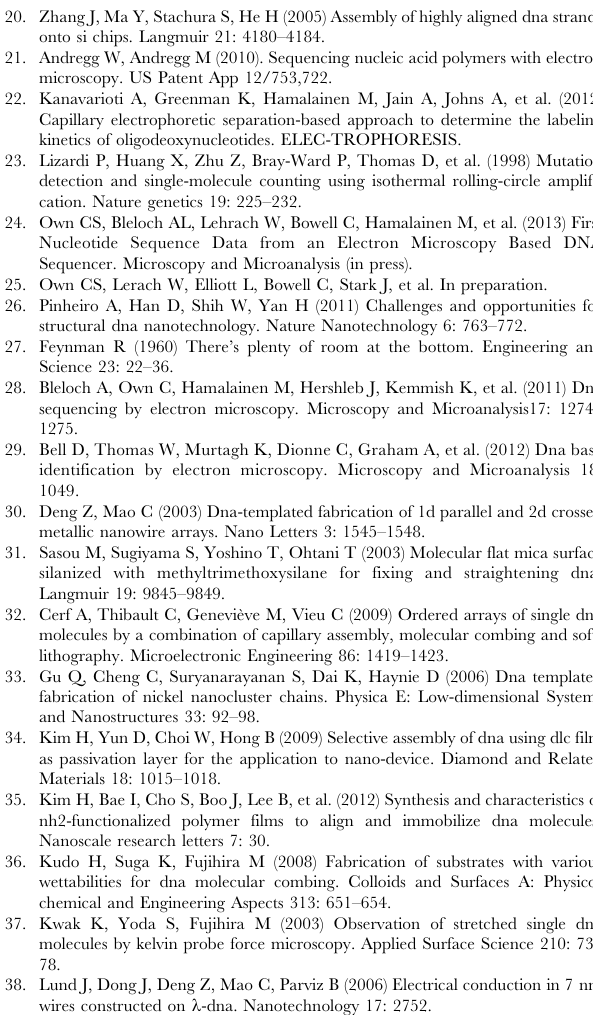
Figure S7 Future work with needle arrays to improve throughput. ( A ) One scheme to improve throughput via a needle array. ( i ) A ‘‘pool’’ containing long DNA molecules is aligned with an array of glass micro-needles treated with PMMA. A small lateral offset is applied to each row to avoid strand overlap. ( ii ) The entire array is inserted into the solution. ( iii ) Multiple DNA molecules are suspended at the liquid-air interface. A motorized stage supporting a PDMS substrate, or TEM support similar to the cantilever discussed in Text S1, is moved across the surface of the pool in order to collect the extracted strands. ( iv ) The collected strands can now be imaged via fluorescence microscopy or transmission electron microscopy, depending on the substrate. ( B ) Prototype ultra-high-aspect ratio microfabricated needle arrays to be studied in future work. Needle tips have , 10–20 nm radius of curvature. (TIF) File S1 Microfabrication of ‘‘cantilever’’ EM grids designed for use with